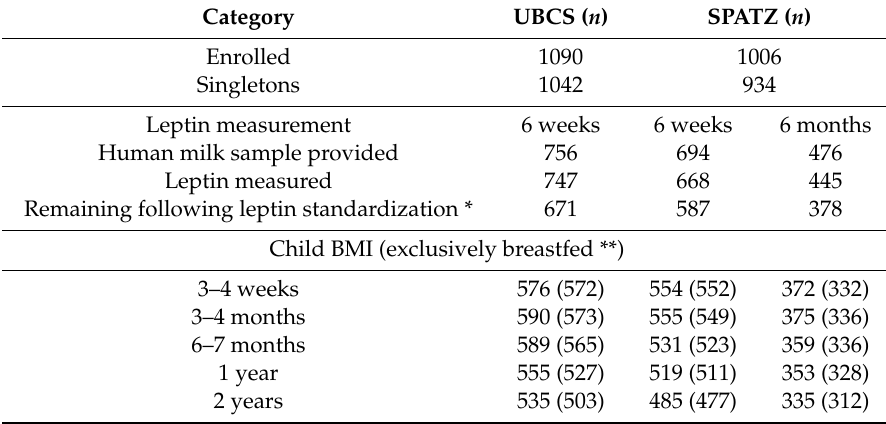
Table 2. Participation of children in the UBCS and SPATZ analyses.